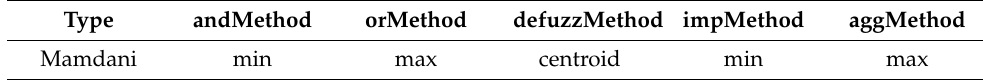
Table 6. MATLAB fuzzy inference functions used.